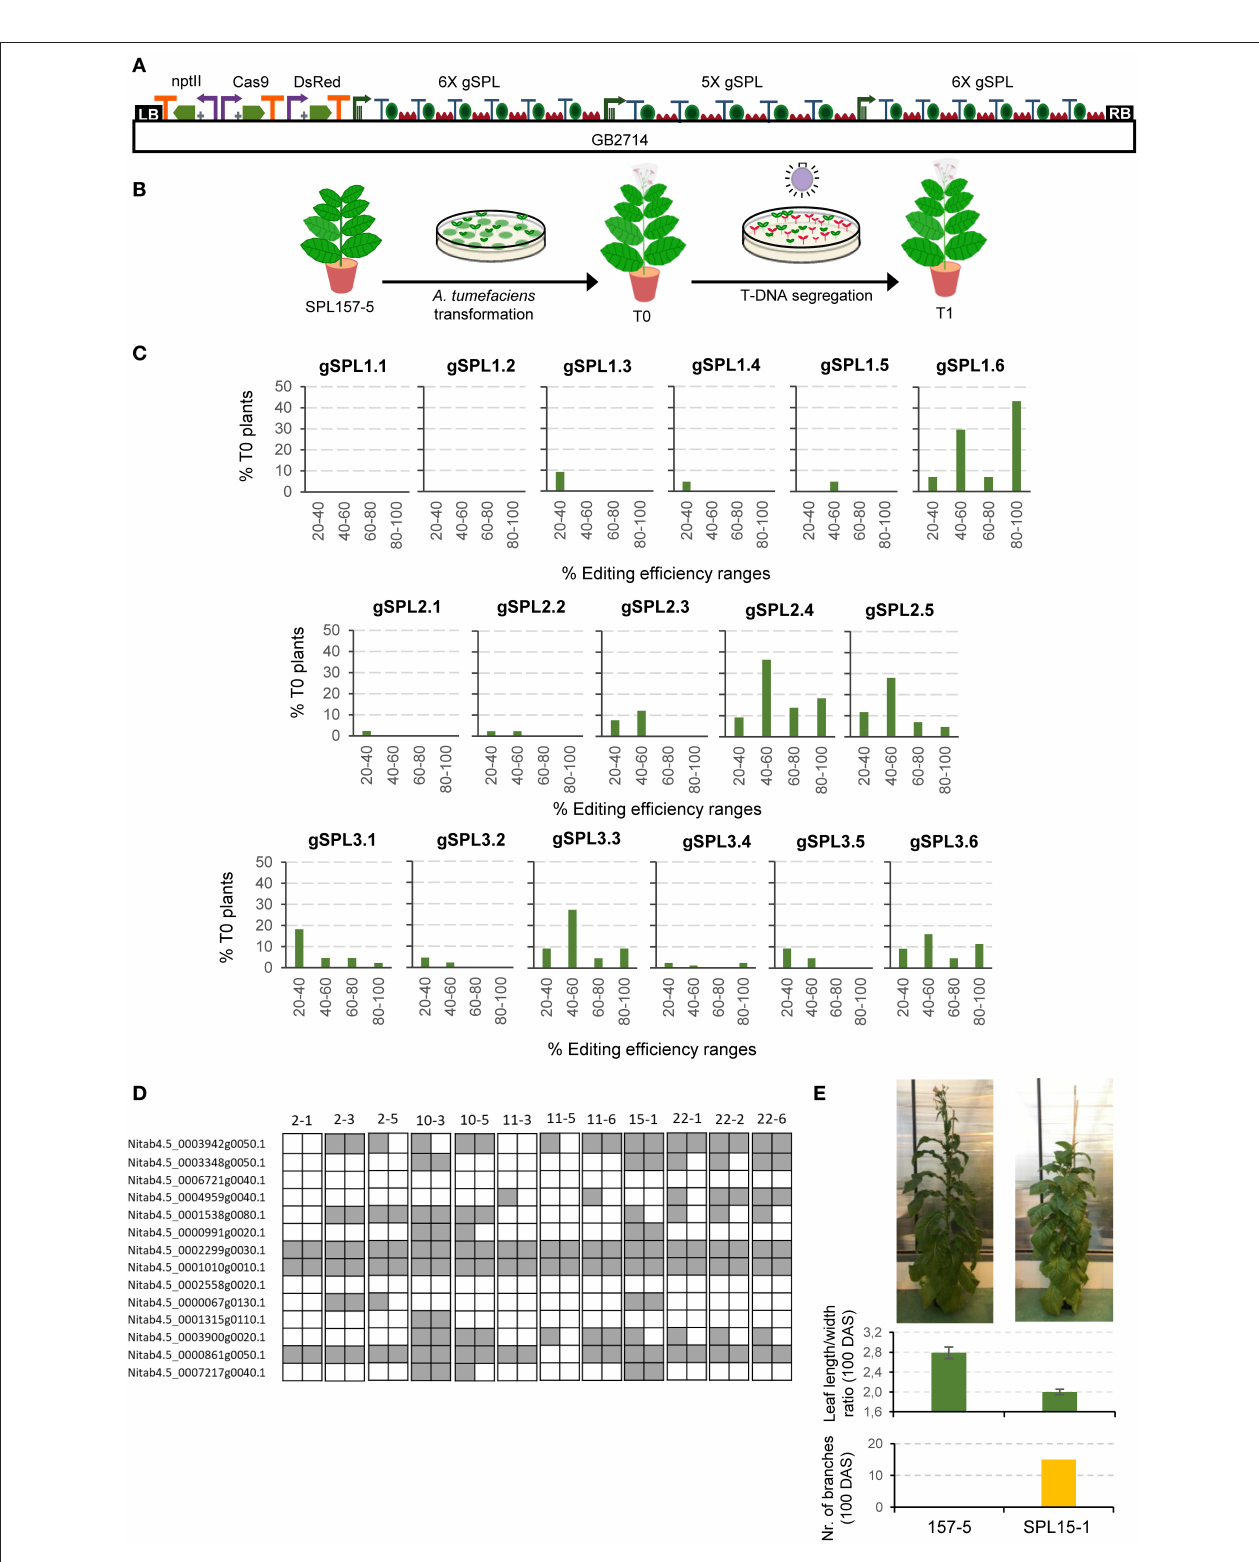
FIGURE 2 | Cas9 guide RNAs editing efficiencies in tobacco stable transformation. (A) Construct including 17 gRNAs (6X + 5X + 6X) targeting SPL genes that was used for A. tumefaciens transformation. (B) Schematic representation of tobacco transformation with A. tumefaciens . (C) gRNA efficiency for each position in the